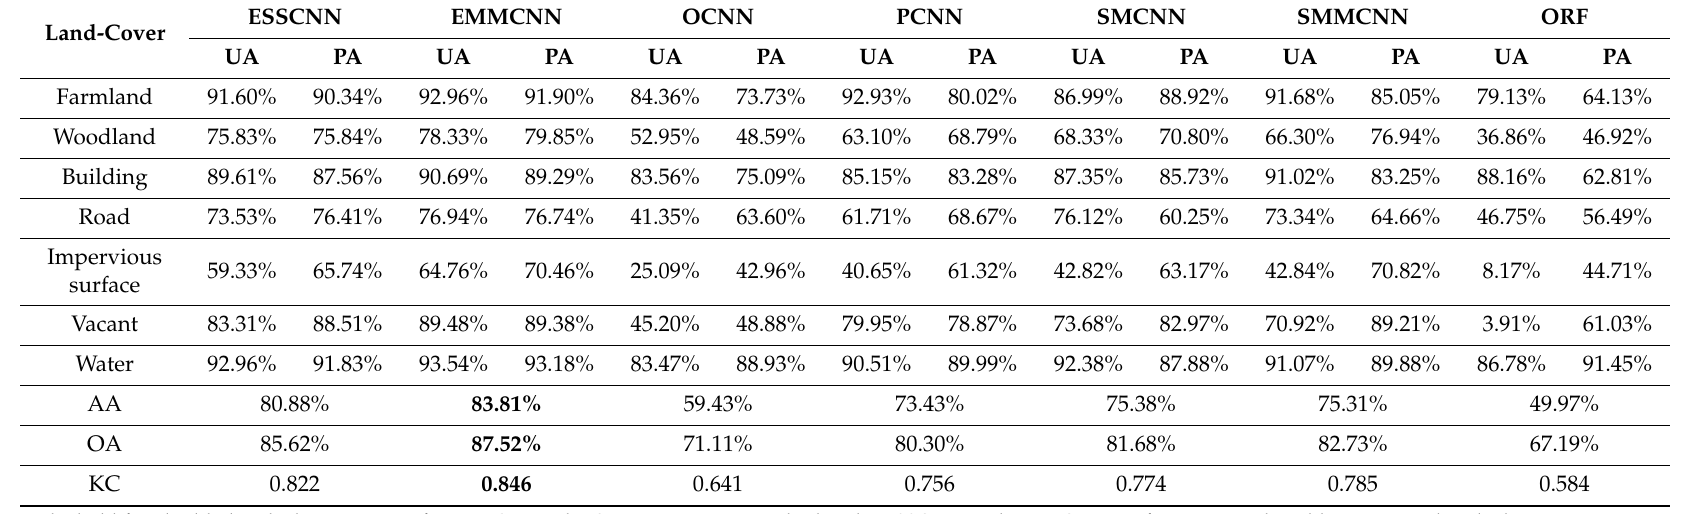
Table 12. Classification accuracy comparison amongst ESSCNN, EMMCNN, OCNN, PCNN, SMCNN, SMMCNN, and ORF methods for the Yuecheng testing